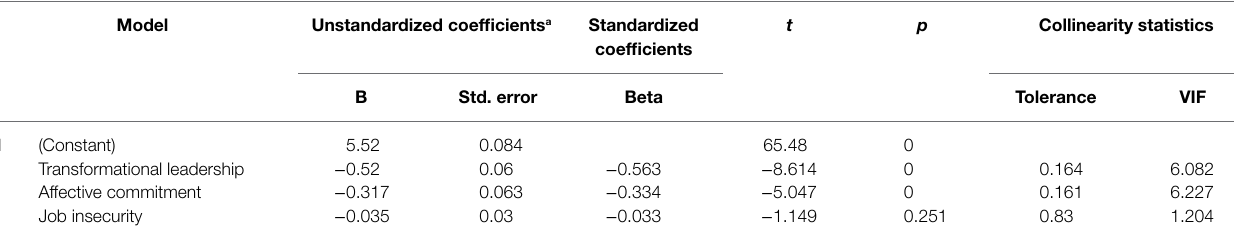
TABLE 3 | Tolerance and VIF analysis. Model